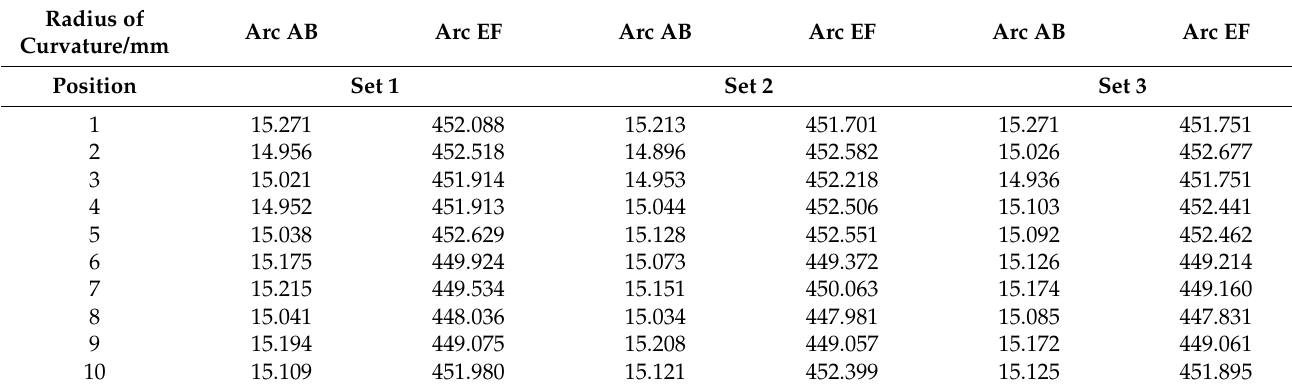
Table 7. Three sets of wheel profile curve measuring